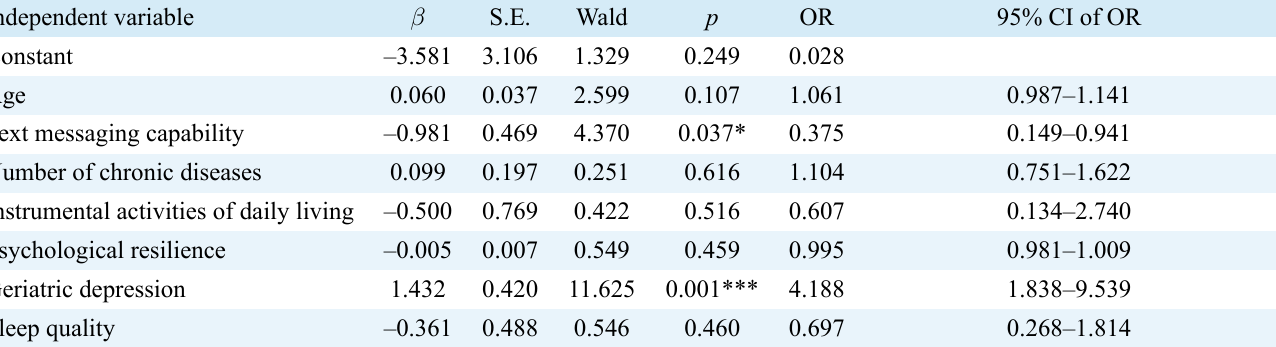
TABLE 3. Results from logistic regression on cognitive function (n =